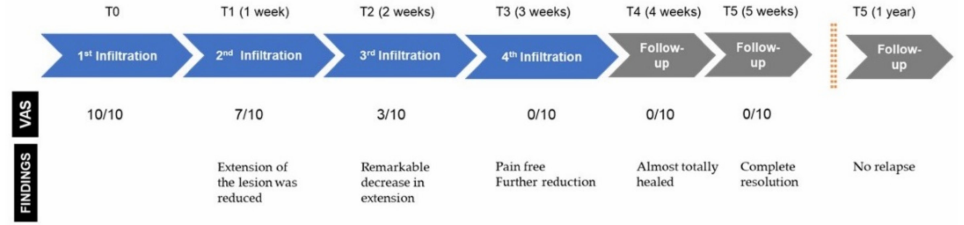
Figure 6. Timeline of the treatment and main